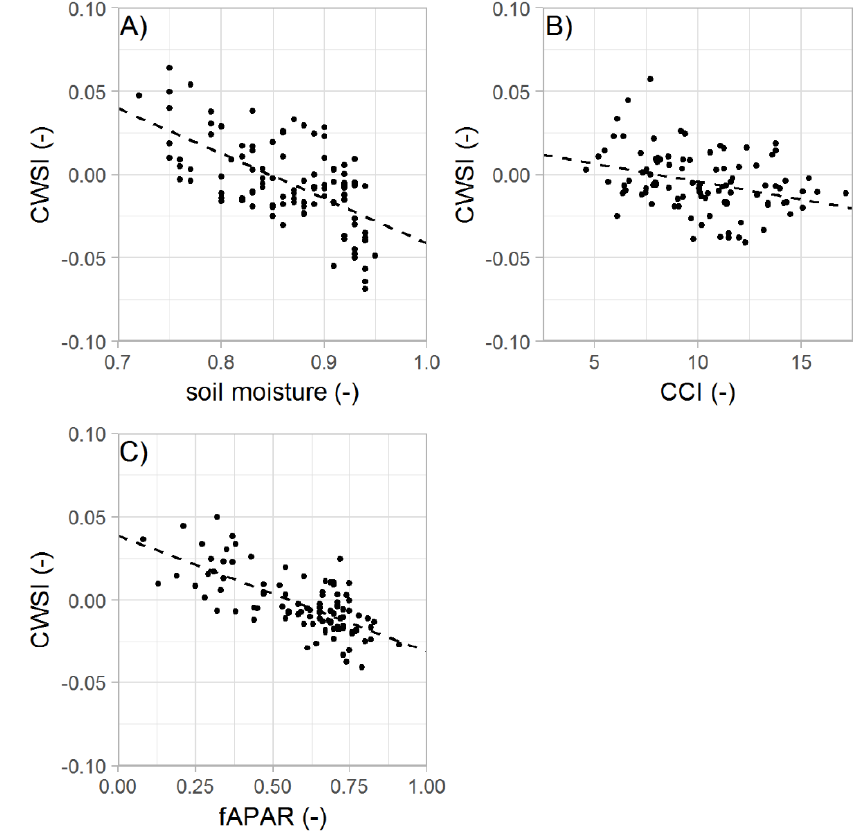
Figure 8. Dependence of CWSI on ( A ) soil moisture, ( B ) chlorophyll content index (CCI), and ( C ) the fraction of absorbed photosynthetically active radiation (fAPAR) for all measured plots in both research areas; the dashed line shows the linear fit. Table 4. Pearson’s correlation coefficient for the relation between CWSI and field measurement with its p-value and number of measurements used for calculation.